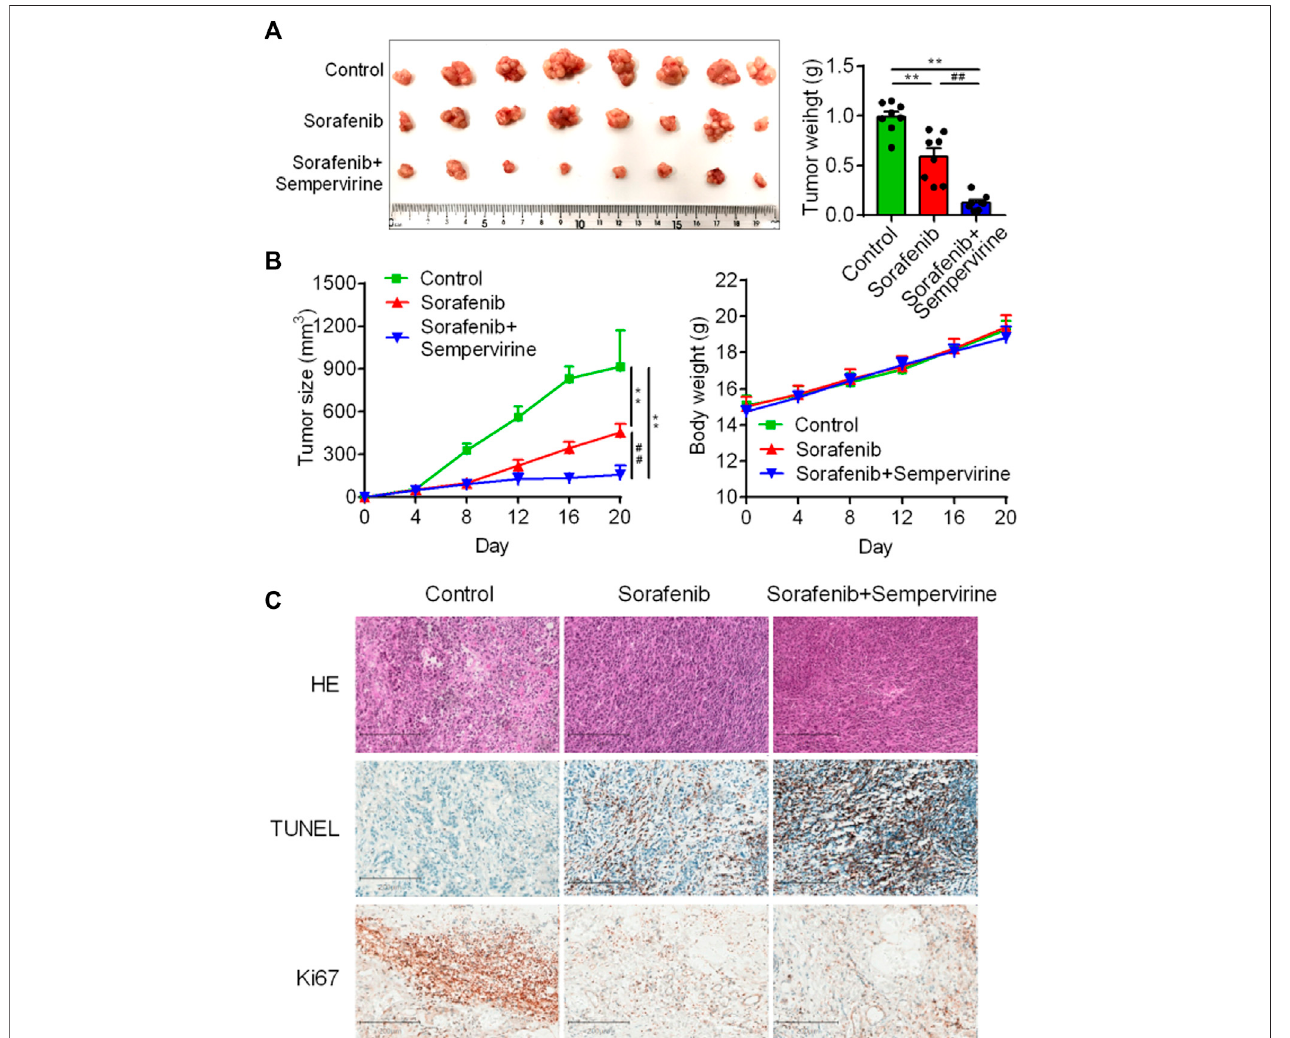
FIGURE 6 | Sempervirine enhanced anti-tumor activity of sorafenib. (A) Representative bioluminescence images of HepG2 hepatic tumors in mice treated with sempervirine and sorafenib for 2 weeks. (B) Quanti fi cation of tumor volumes and tumor growth curves in mice. (C) Representative HE staining, Ki67 and TUNE of xenografts treated with the sempervirine and the combination group. Scale bars (cid:2) 200 μ m. Data are presented as means ± SEM. ** p < 0.01 vs . Control, ## p < 0.01 vs . the combination.